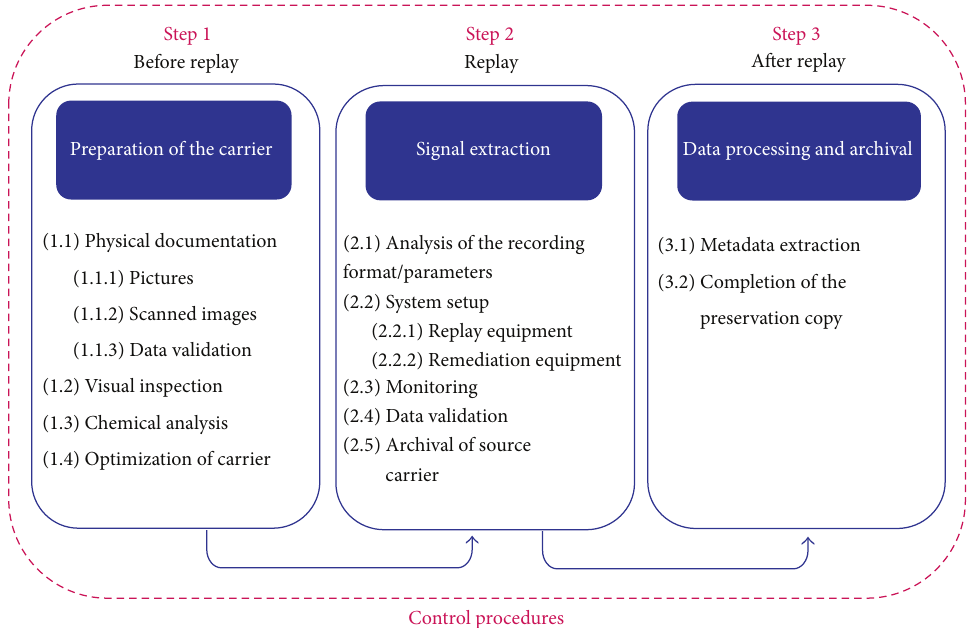
Figure 3: General scheme of the remediation process, from the source carrier to the preservation copy.